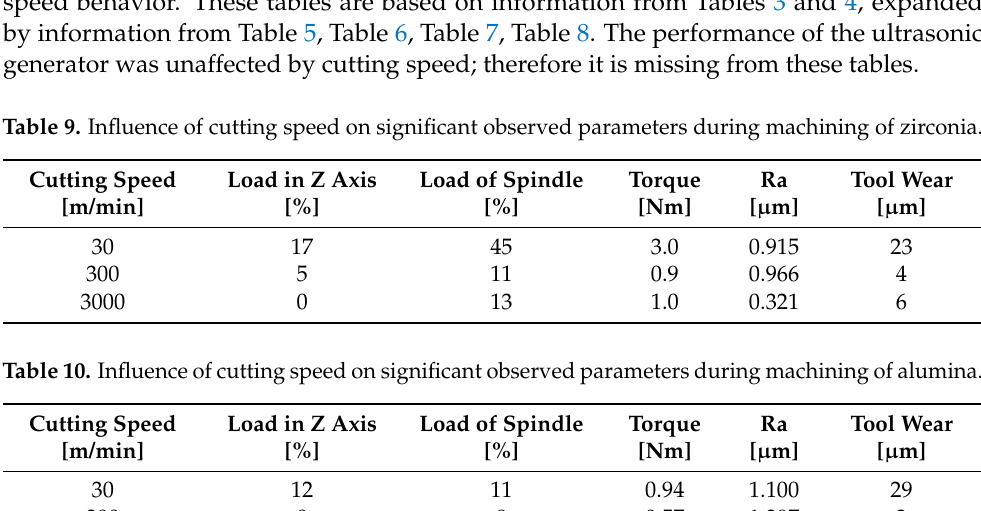
Table 9. Influence of cutting speed on significant observed parameters during machining of zirco- nia.